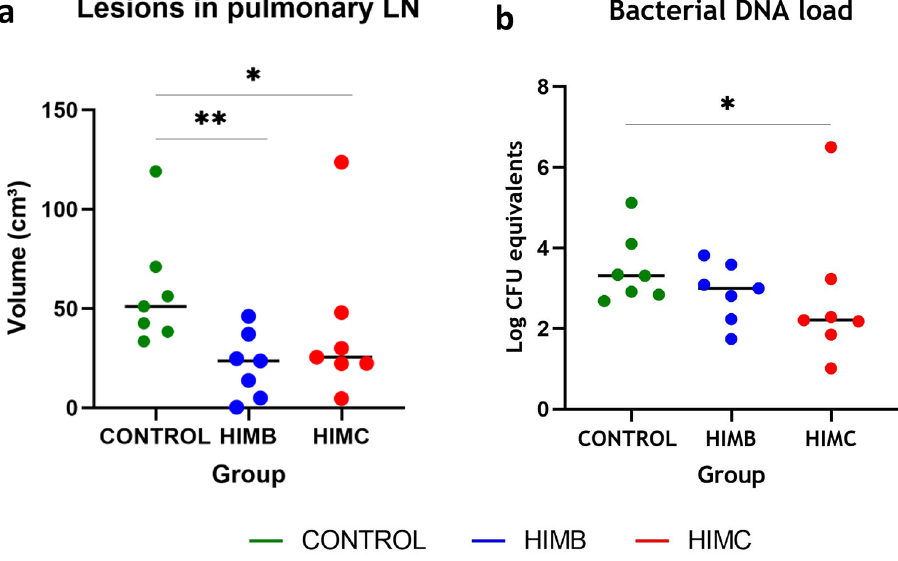
Figure 7. Post-mortem results in pulmonary lymph nodes (LN). ( a ) Volume of lesions in LN expressed in cm 3 . ( b ) M. caprae DNA load in LN measured by quantitative PCR and expressed as Log 10 CFU equivalents. * P < 0.05, ** P < 0.01, Kruskal–Wallis with post hoc Dunn tests.